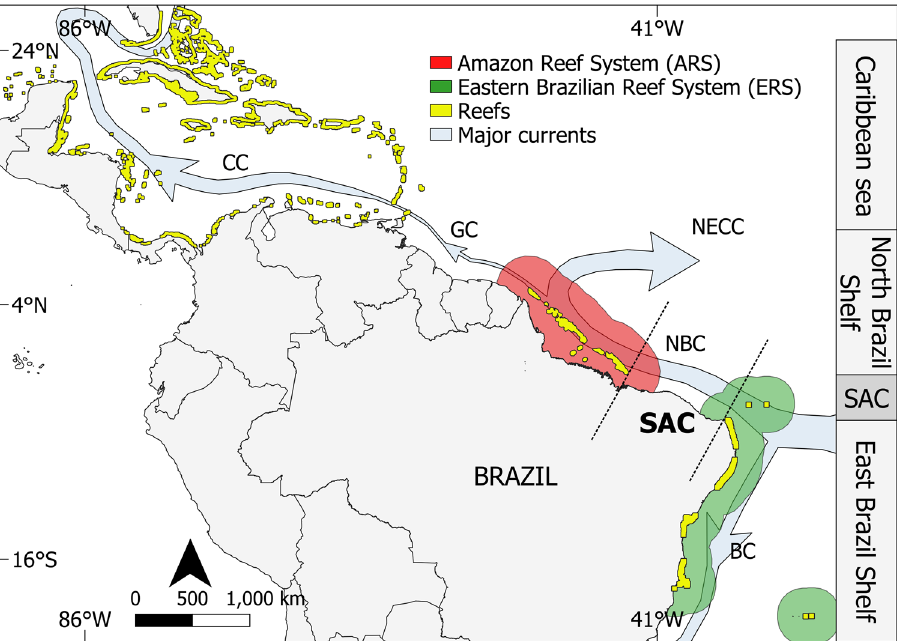
Figure 1. West coast of the Atlantic Ocean showing the countries of Central and South America, large marine ecosystems, major reef systems, and main ocean currents. Areas of reefs and reef systems are out of scale. Shallow reef distribution modified from 15 and Amazon reefs based on 8 . SAC Brazilian semi-arid coast, BC